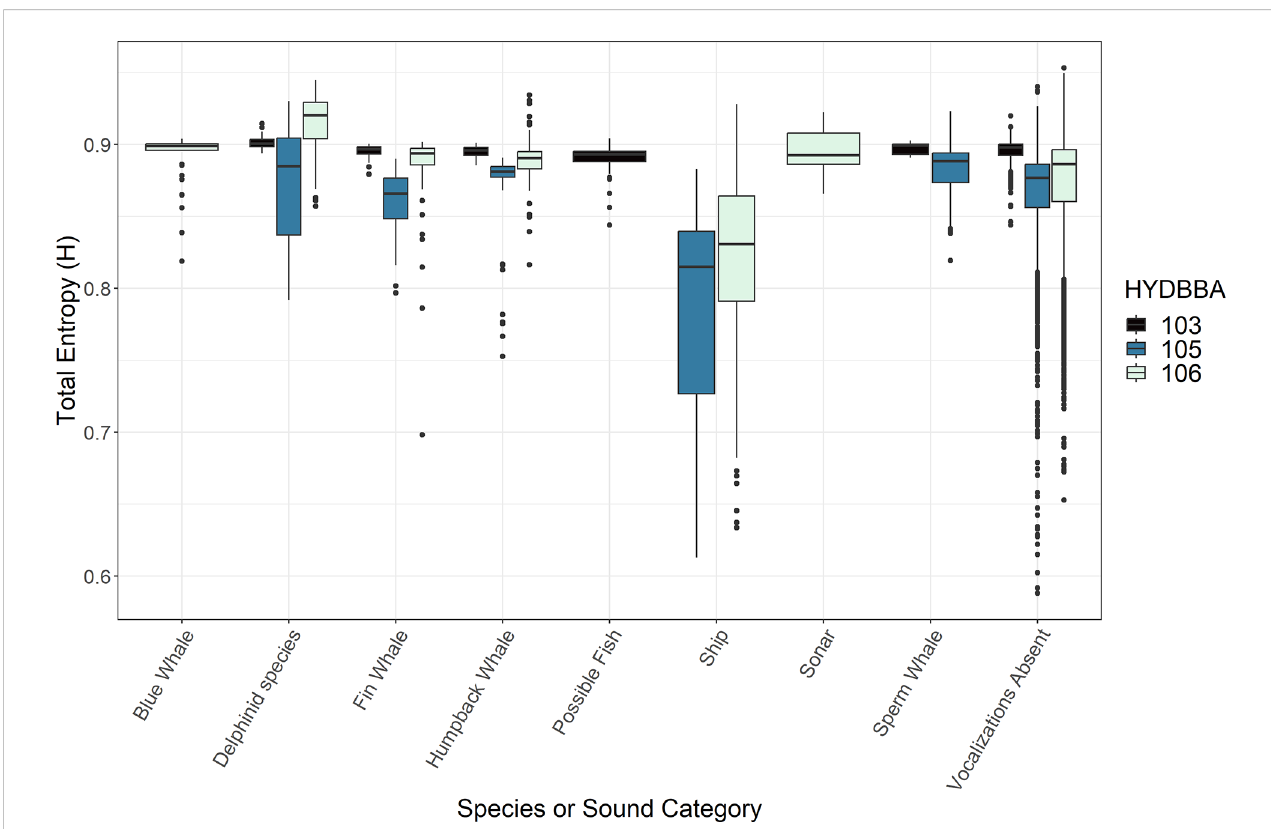
FIGURE 5 Box plots representing measurements of Total Entropy (H) associated with underwater sounds. Data are organized by recorders located on the shelf (106), the slope (105) and at the base of the slope (105). Marine mammal species and human-made sounds vary for each recorder resulting in some sound types with only one or two box plots. All recorders include a plot for data that contained no annotated sound (labeled ” Vocalizations Absent “